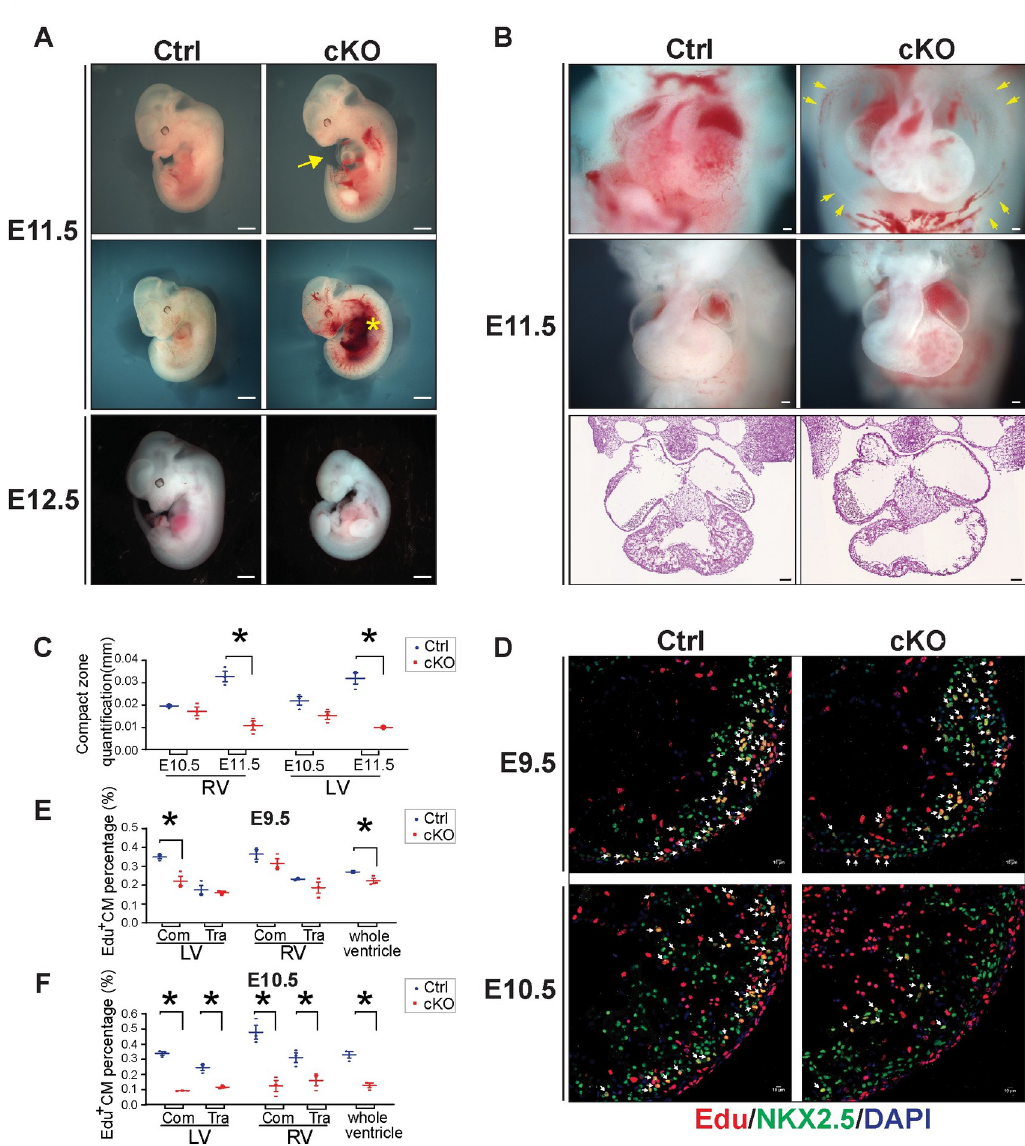
Fig 1. MED30 is essential for early cardiac development. (A) Whole embryonic morphology of constitutive cardiomyocyte- specific knockout (cKO) and control (Ctrl) littermates at E11.5 and E12.5. Arrow: edema chest; Asterisk: hemorrhage. Scale bar: 1 mm. n = 3. (B) Cardiac morphology (Top and middle) and H&E images (Bottom) of Med30 cKO embryos and Ctrl littermates at E11.5. Arrow: edema chest. Scale bar: 100 μ m. n = 3. (C) Quantitation of compact zone thickness in Med30 cKO and Ctrl hearts at E10.5 and E11.5. RV: right ventricle; LV: left ventricle. n = 3. (D) Representative immunostaining images of EdU- labeled (red) heart sections from Med30 cKO and Ctrl mice at E9.5 and E10.5, using an antibody against NKX2.5 as cardiomyocyte marker (green). DNA is stained with DAPI (blue). Arrow: Edu-positive cardiomyocytes. Scale bar: 10 μ M. (E-F) Quantification (%) of Edu-positive cardiomyocytes (CM) in (E) E9.5 and (F) E10.5 Ctrl (blue) vs. Med30 cKO (red) heart areas as indicated. Com: compact zone; Tra: trabeculae. n = 3. Data are represented as the mean ± SEM. � P < 0.05, by 2-tailed Student’s t test.